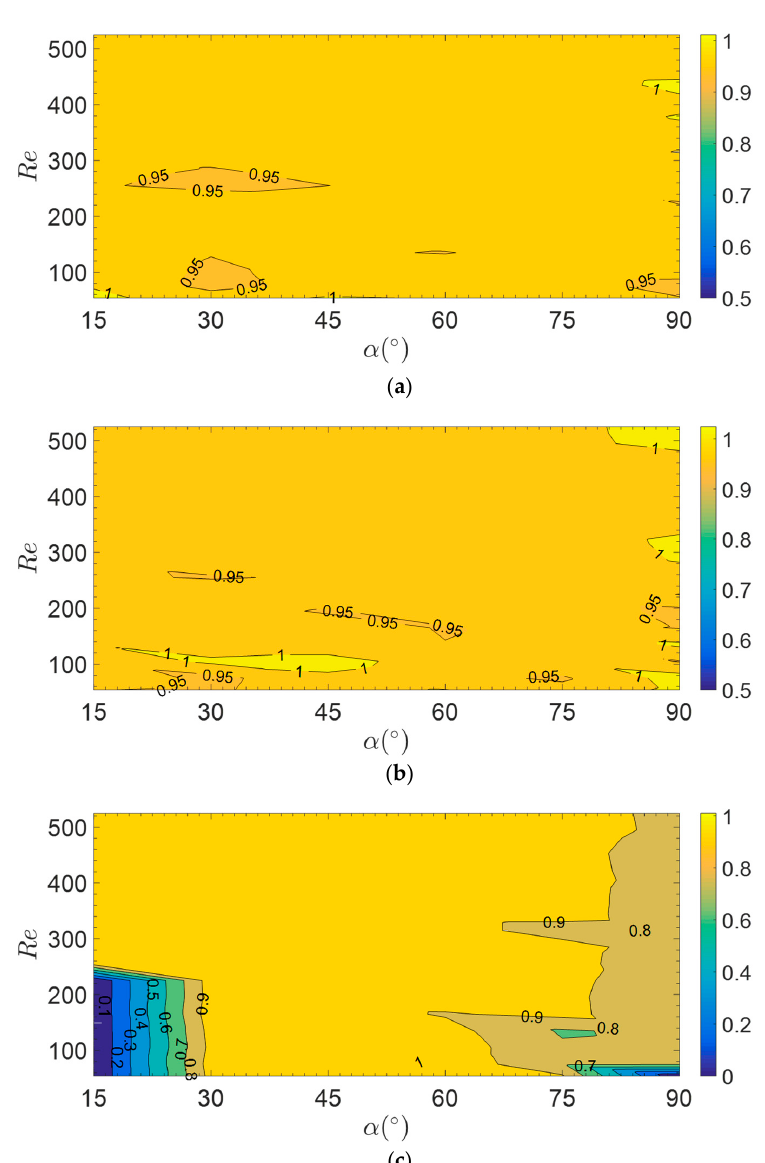
Figure 7. Contour maps of frequency ratio versus the inclination angle and Reynolds number at di ff erent locations along the bent cylinder inclined leg: s / L i = 0 ( a ), s / L i = 0.5 ( b ), and s / L i = 1 ( c